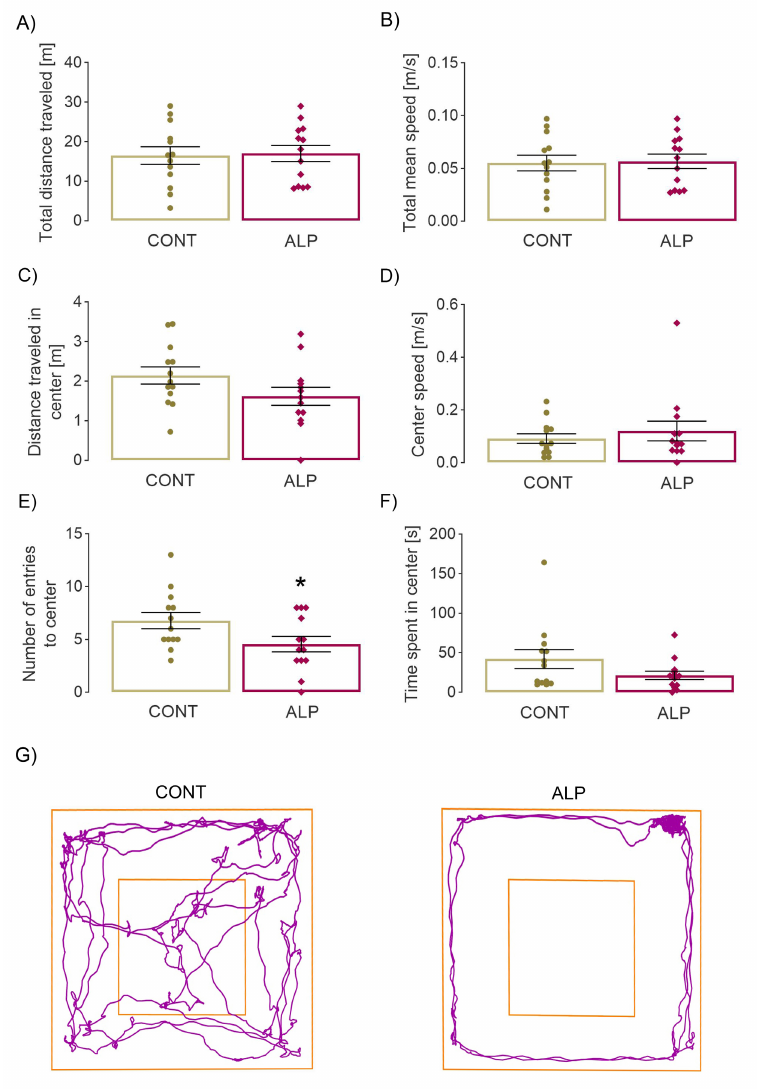
Figure 1. Effect of prolonged 14 days ALP treatment on behavioral parameters in open field test. ( A ) Total distance traveled in arena [m], ( B ) total mean speed (m/s), ( C ) distance traveled in center [m], ( D ) mean speed in center [m/s], ( E ) number of entries to center, ( F ) time spent in center [s], ( G ) representative track plots of VEH (left) and ALP (right) group. Data were statistically analyzed by two-tailed t -test and expressed as percentage of the mean values of CONT group ± SEM (dots in the graphs represent values of individual animals). Symbols indicate significant differences between CONT and ALP group: * p < 0.05; animals per group: 13.